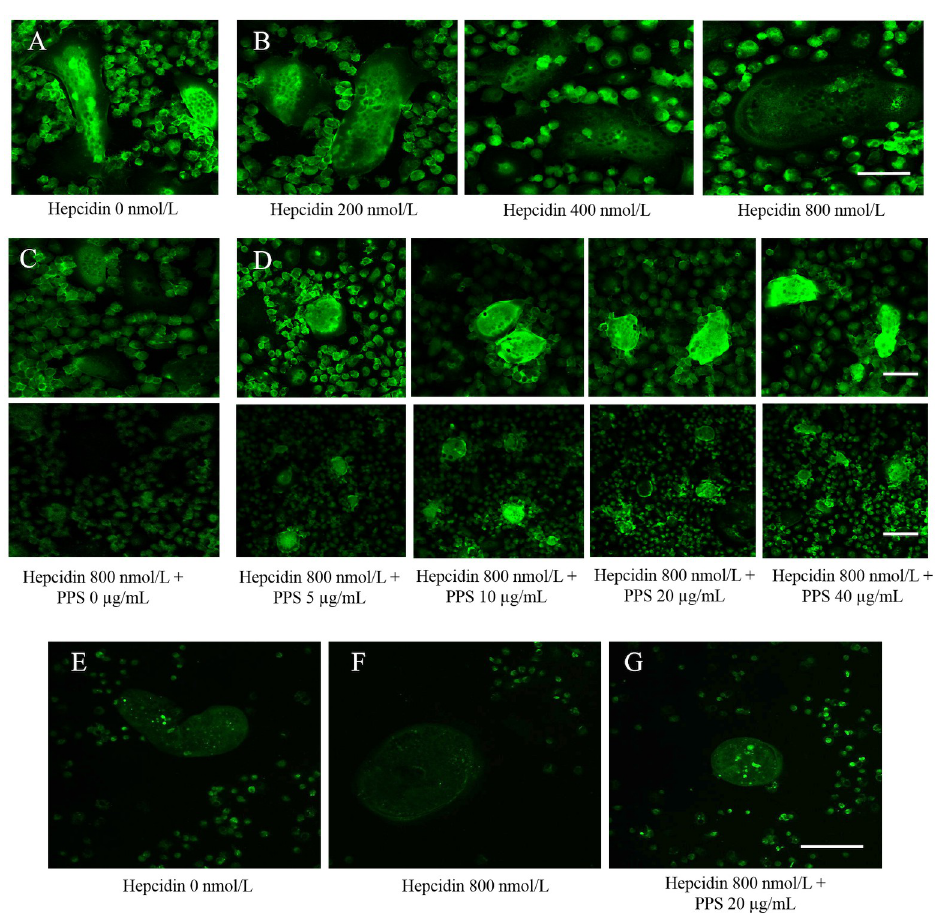
Fig 5. Immunofluorescence images. (A) Immunofluorescence analysis of ferroportin 1 (FPN1) protein. Canine bone marrow derived OC were treated with rabbit anti-ferroportin 1 after 20 hours treatment of hepcidin (200, 400 and 800 nmol/L) to visualize the expression of FPN1 protein. The figure shows the strong detection of localization of FPN1 at the membrane of hepcidin untreated OC (control). (B) The green fluorescence intensity significantly weakened toward the higher concentration of hepcidin (800 nmol/L). Scale bar- 50 μ m. (C) PPS inhibits the hepcidin-induced FPN1 internalization and degradation. OC were treated with rabbit anti-ferroportin 1 after 20 hs treatment of PPS (5, 10, 20 and 40 μ g/mL) and hepcidin 1 (800 nmol/L) to visualize the expression of FPN1 protein. The figure shows the strong inhibition of localization of FPN1 at the membrane of hepcidin treated OC (control). (D) Heparin induced FPN1 internalization and degradation was inhibited with higher concentrations of PPS (5, 10, 20 and 40 μ g/mL). Higher the fluorescence intensity was visualized toward the 40 μ g/mL PPS. Scale bars- 50 and 100 μ m. (E) Confocal microscopy analysis of iron concentration in OC. Cell medium was replaced with fresh medium containing 25 ng/mL M-CSF, 50 ng/mL RANKL and 800, nmol/L hepcidin 1 and 20 μ g/mL PPS and allowed to incubate for 20 h. Fluorescence of the Phen Green FL is quenched upon binding iron and emission intensity was weakened when the iron concentration is high. E, shows high fluorescence intensity in untreated cells implying low intracellular iron. (F) Fluorescence images showed that intracellular iron concentration was increased (weakened fluorescence intensity) with hepcidin 800 nmol/ L compared to the untreated cells. (G) fluorescence images have proven the inhibitory effect of PPS on hepcidin- induced iron accumulation by visualizing greater intensity of fluorescence at 20 μ